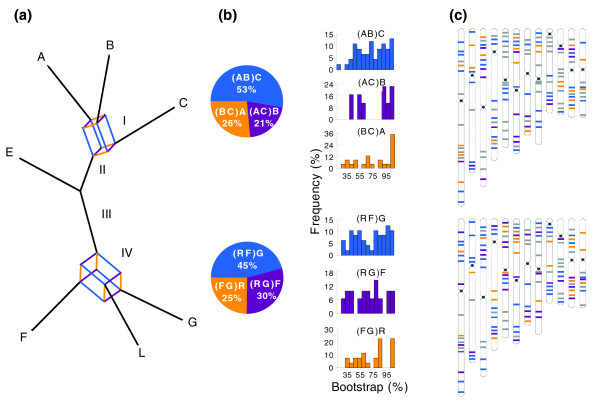
Genome-wide incongruence. A, B, C, E, F, and G represent Oryza genome types and L represents the outgroup, Leersia. (a) Consensus network constructed from ML trees at a threshold of 0.15. The two boxes indicate the relatively high levels of incongruence among gene trees associated with internal branches I and IV. Branch length is proportional to the frequency of occurrence of a particular split of all gene trees. R represents the rest of the genome types, including A-, B-, C-, and E-genomes. Color schemes: for the box associated with branch I, blue, orange, and purple illustrate splits supporting alternative topologies, (AB)C, (BC)A, and (AC)B, respectively; for the box associated with branch IV, blue, orange, and purple illustrate splits supporting alternative topologies, (RF)G, (FG)R, and (RG)F, respectively. (b) Pie graphs indicate the proportions of gene trees that support alternative splits in the corresponding boxes at the left. Histograms at the right illustrate the distribution of ML bootstrap support for the corresponding split (in the corresponding colors). (c) Illustration of the relative physical locations of the 142 sampled genes on the 12 rice chromosomes based on rice genome sequences. The colors indicate genes supporting a split or topology coded in the same color in the corresponding boxes on the consensus network. Genes coded in gray are those that had no input in the topology illustrated in the pie graphs and those not included for the construction of the consensus network because of missing data.